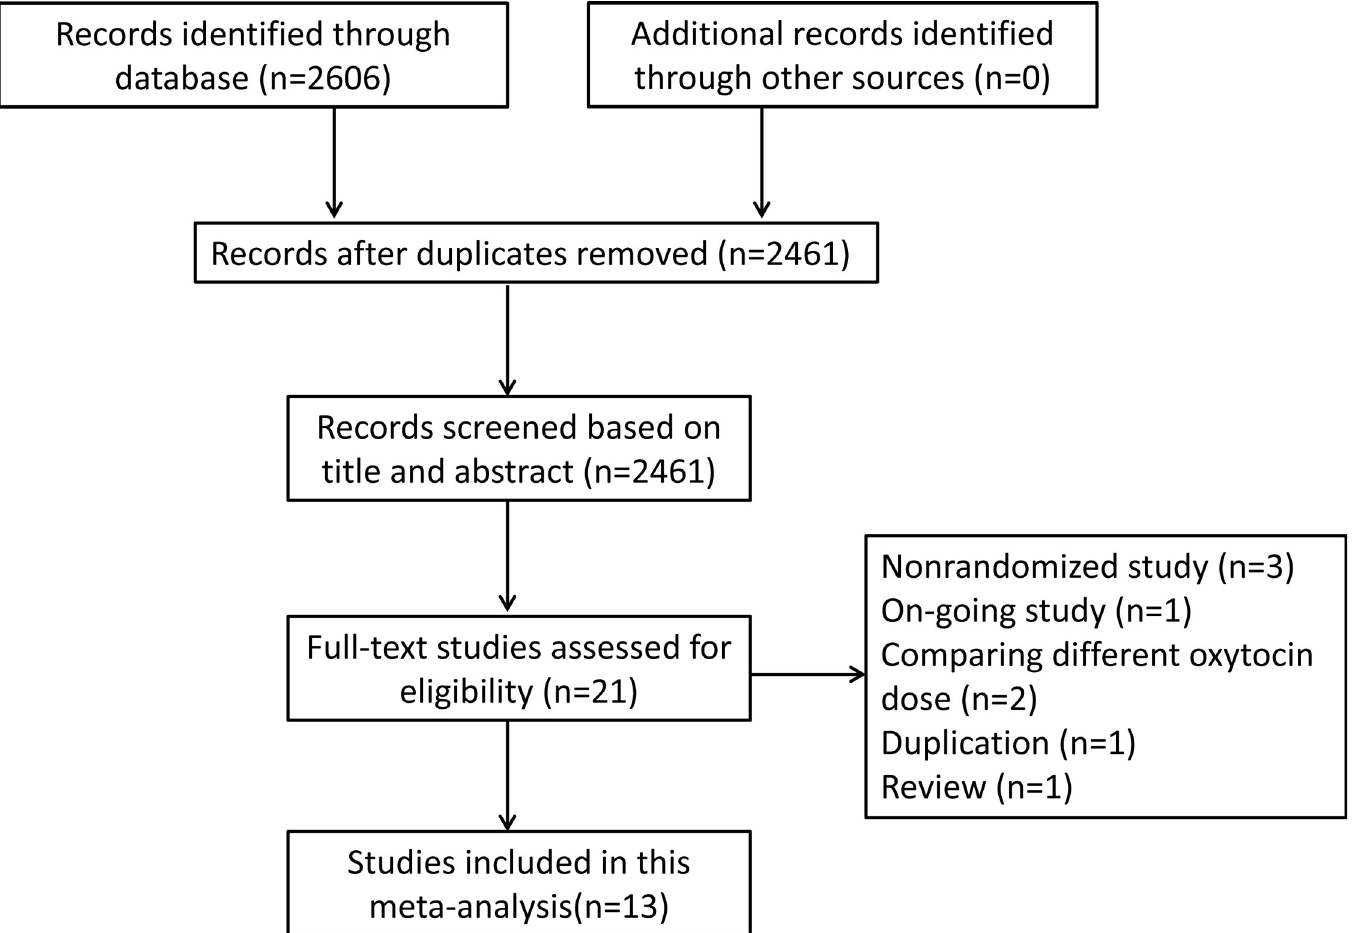
Fig 1. The flow chart of literature selection process.